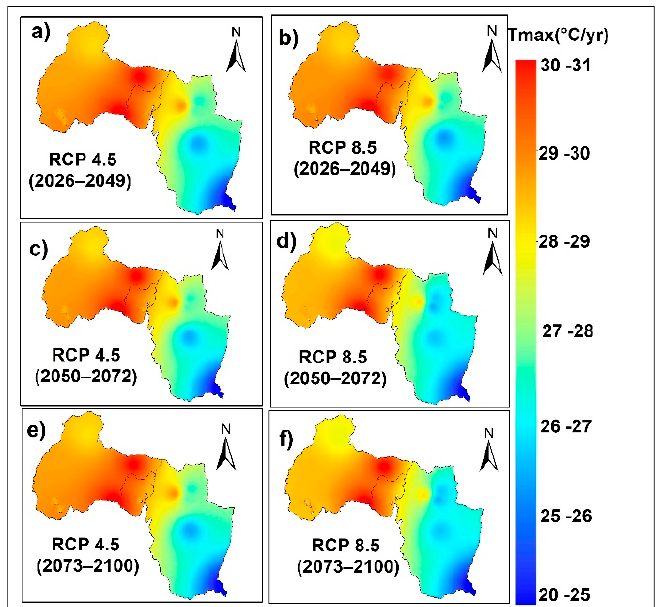
Figure 6. Spatial distribution of CNRM-CM5 model mean annual T max (°C) within the ZLB for RCP 4.5 and 8.5 scenarios and three future periods: ( a ) near-term RCP 4.5, ( b ) near-term RCP 8.5, ( c ) mid-term RCP 4.5, ( d ) mid-term RCP 8.5, ( e ) far-term RCP 4.5, and ( f ) far-term RCP 8.5.